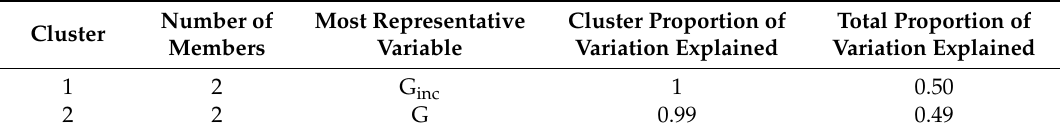
Table 5. Cluster summary, reporting the number of variables in each cluster and the variation explained by cluster component.